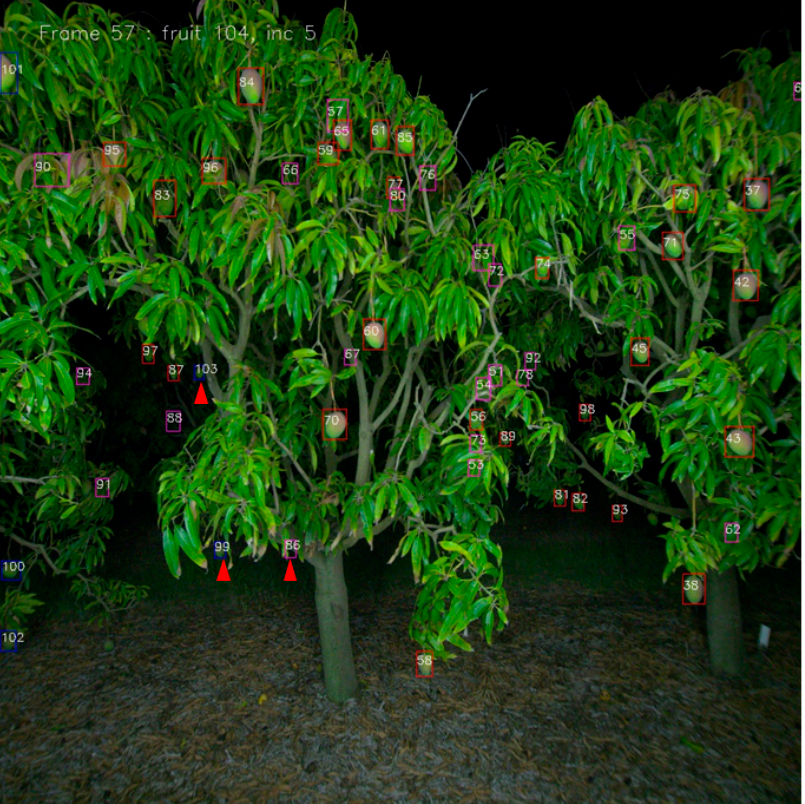
Figure 6. A tracking example: red bounding boxes indicate tracked fruit with valid assignments; pink indicates predicted location for fruit on the track list that were not detected in the current frame; blue indicates a new fruit detection. Numbering on fruit is in order of detection. Red arrows point to fruit mentioned in text.